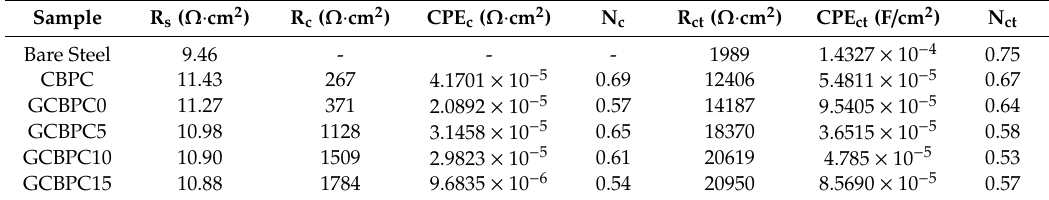
Figure 9. Nyquist and Bode plots of CBPCs. Table 6. EIS parameters from Nyquist and Bode plots.